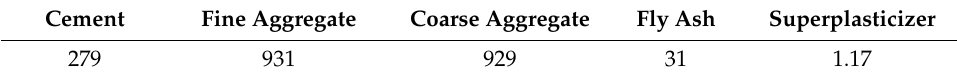
Table 1. Mix proportion of concrete (kg / m 3